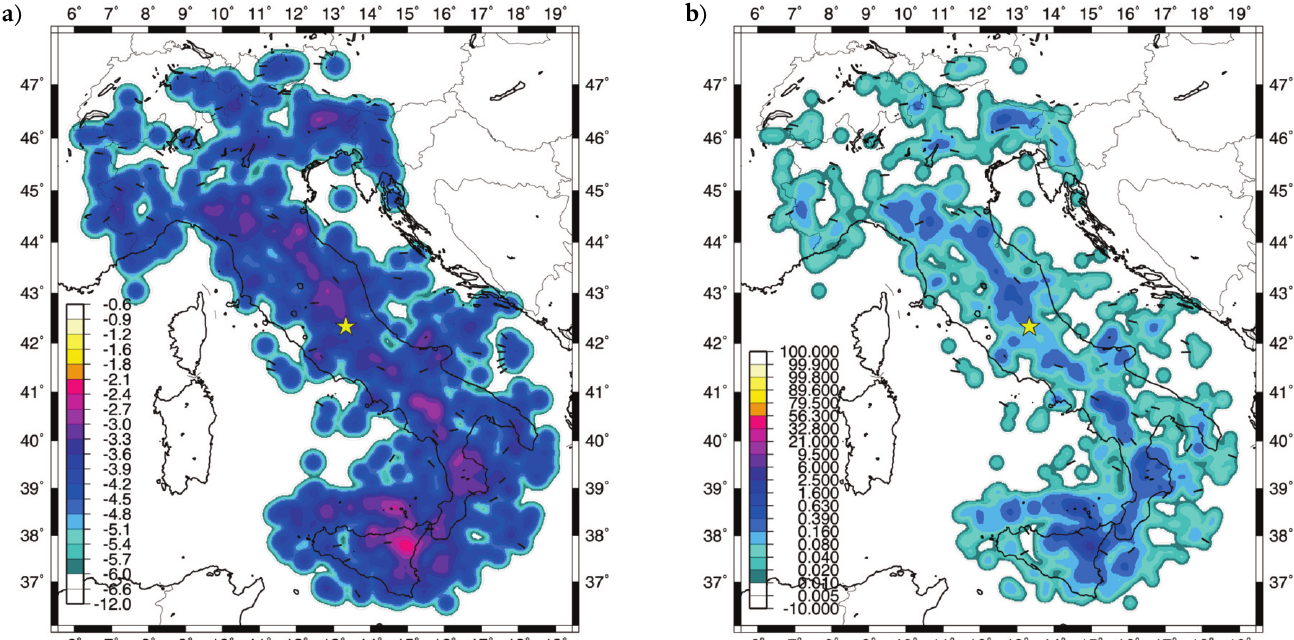
≥ 5.0 events per year in each cell) for the CSI 1.1 Figure 9. (a) Forecast seismicity rates obtained using 15 km correlation distance (expected number of M L ≥ 2.9 earthquakes from 1984. Yellow asterisk, main shock of the April 6, 2009, L'Aquila earthquake. (b) case, using the spatially smoothed locations of M L ≥ 5.0 predicted in 10 km × 10 km cells around each location. Earthquake rates per km 2 Five-year probabilities given as log rate of events per year for M 10 L can be obtained by multiplying by 10 −2 . For the recurrence time of the seismic activity we assumed a time-independent (Poisson) model, in which the occurrence of an earthquake does not change the probability of occurrence of following